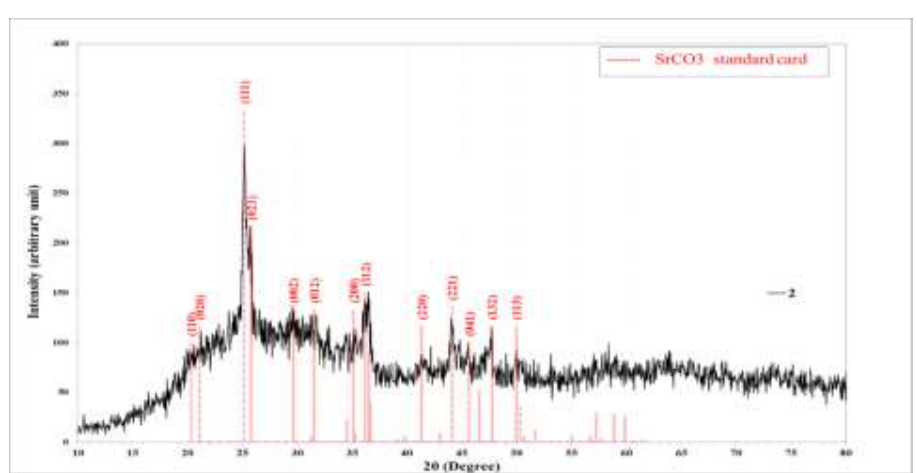
Fig.5: X-ray diffraction CNTs-Sr(OH)